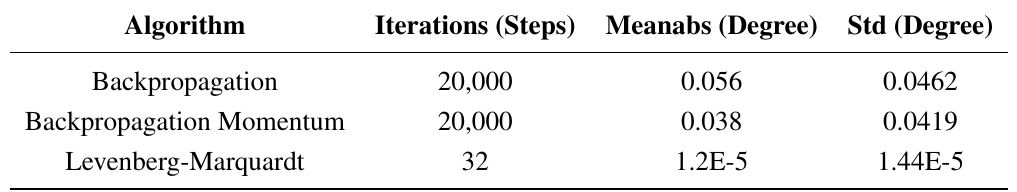
Table 2. Training algorithms’ evaluation. Std, standard